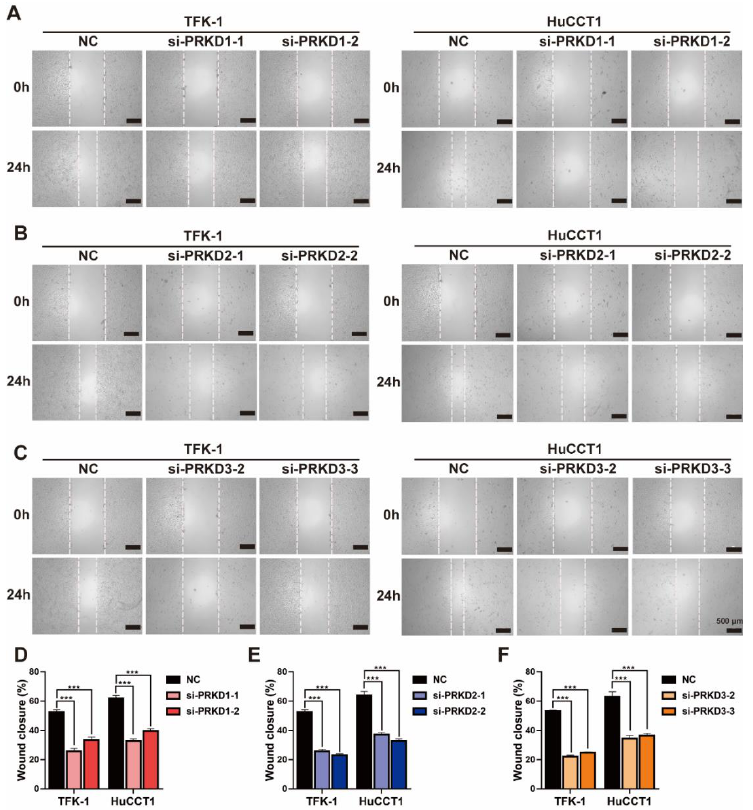
Figure 6. The wound healing assays of CCA cells treated with PKD specific siRNAs: representative phase-contrast images of TFK-1 and HuCCT1 cells at 0 and 24 h transfection with effective siRNAs for ( A ) PRKD1, ( B ) PRKD2, and ( C ) PRKD3, respectively (scale bars = 500 μm); percentage of wound closure that occurred at 24 h after the transfection of each specific siRNA for ( D ) PRKD1, ( E ) PRKD2, and ( F ) PRKD3, respectively. *** p < 0.001, determined by two-way ANOVA. Data are presented with means ± SDs and from three independent experiments.